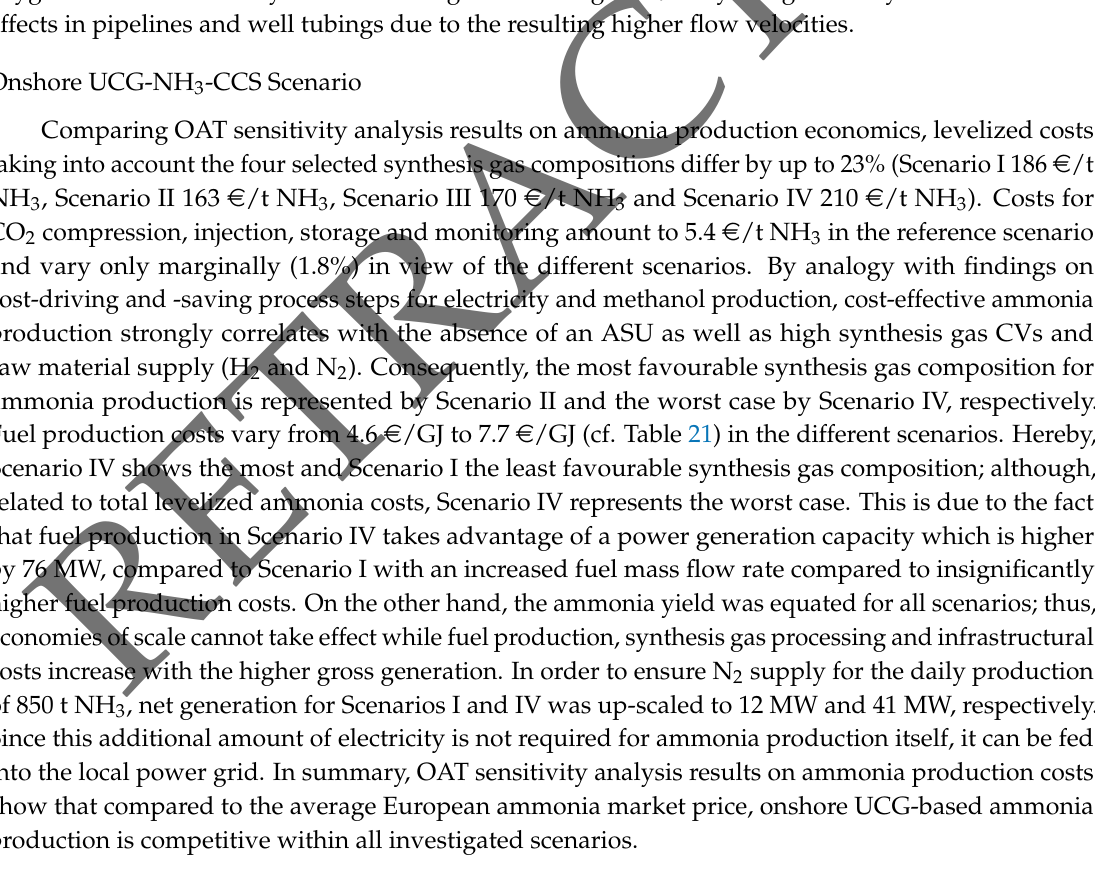
Table 21. Fuel production costs for onshore ammonia production considering different synthesis gas